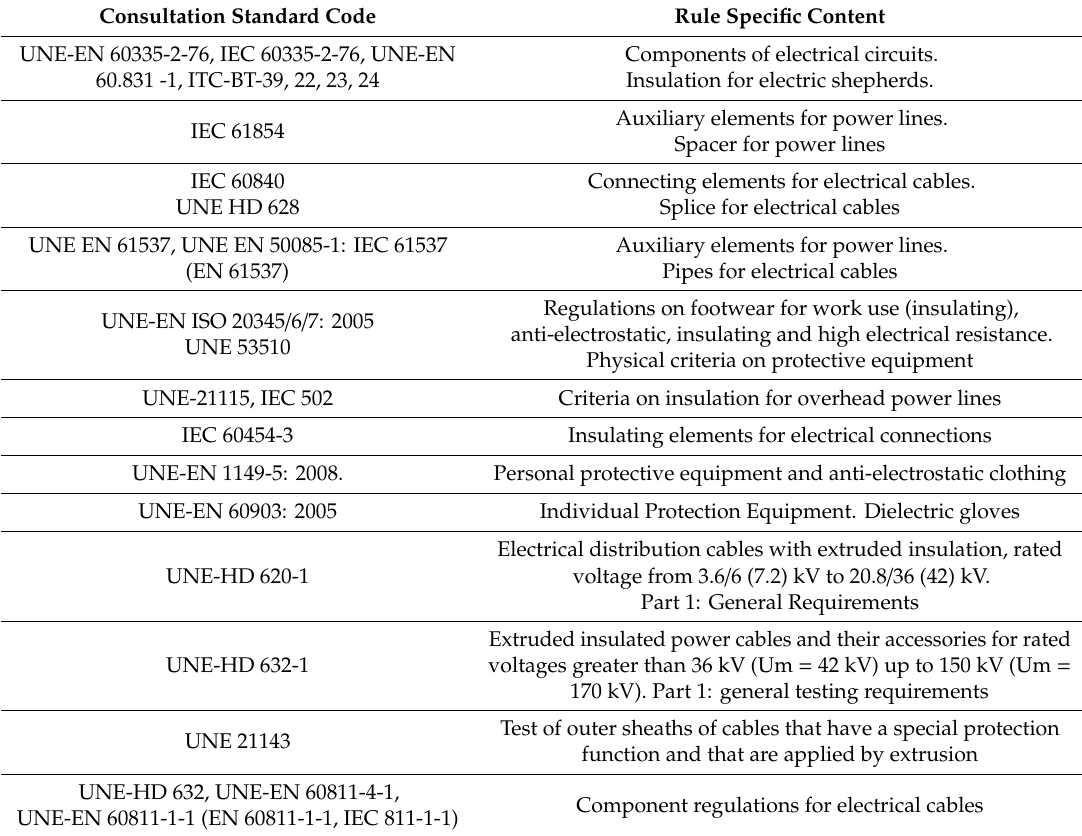
Table 7. Application standards code related: the Spanish Association for Standardization (UNE) and the International Electrotechnical Commission